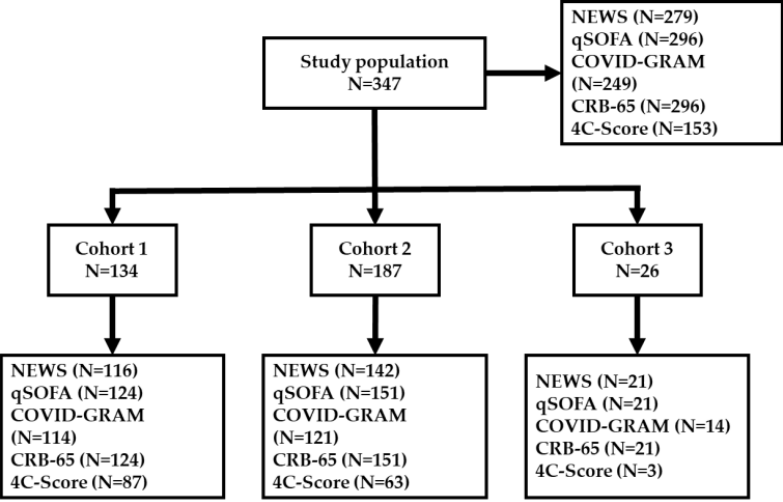
Figure 1. Overview of score calculation. Abbreviations: NEWS , National Early Warning Score; qSOFA , quick sequential organ failure assessment; COVID , coronavirus disease; GRAM , Guangzhou Institute of Respiratory Health Calculator at Admission; CRB , confusion, respiratory rate, blood pressure.